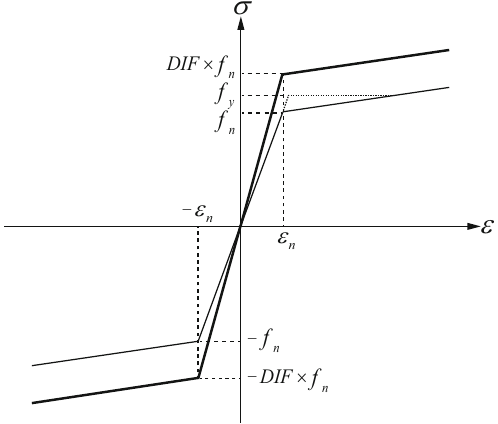
Fig. 2 Monotonic stress–strain relation of